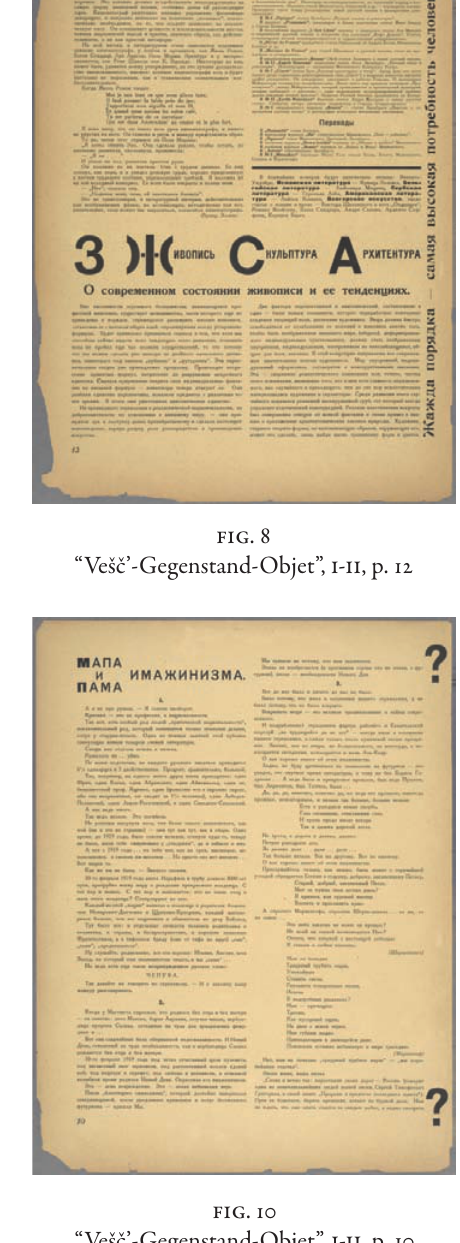
“Vešč’-Gegenstand-Objet”, i-ii, p. 13